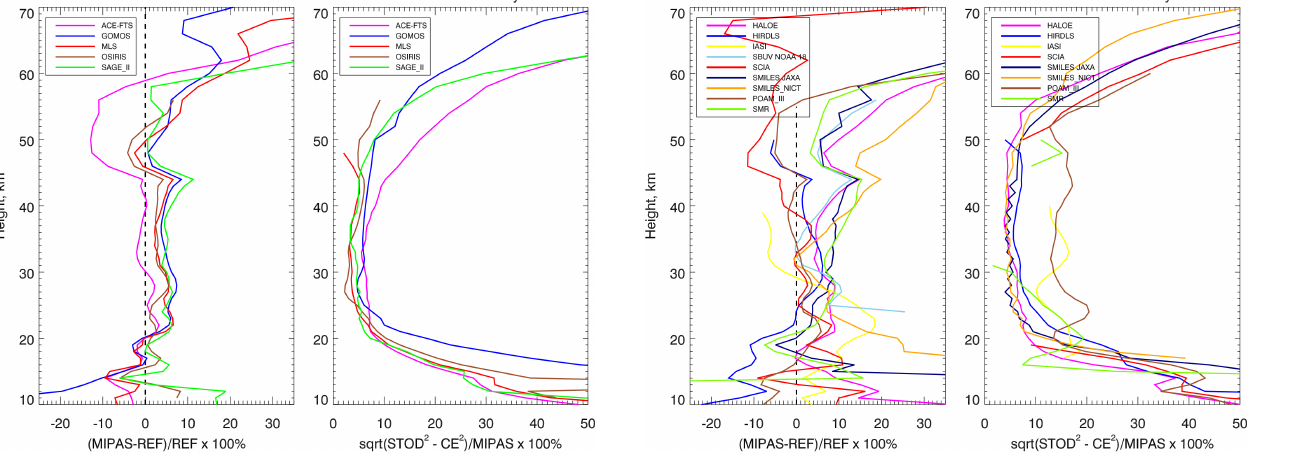
Figure 6. Bias estimation and residual variability (Eq. 6) of MI- PAS ozone profiles with respect to reference instruments that have known bias compared to ozonesondes. No bias correction has been